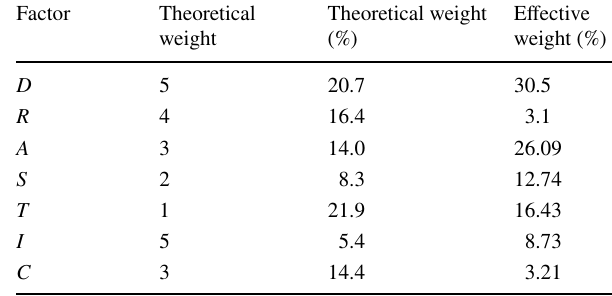
Table 7 Vulnerability classes of the study area DRASTIC conditions